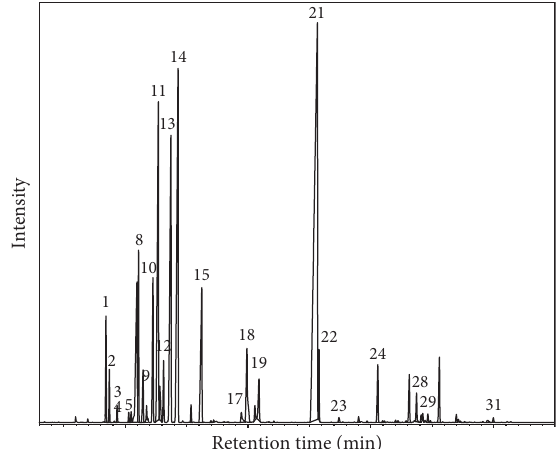
Figure 3: Gas chromatogram of the essential oil of O. vulgare grown at Haldwani (OV3). Table 5: Chemical constituents identified in the EO of O. vulgare cultivated at different altitudes. S.